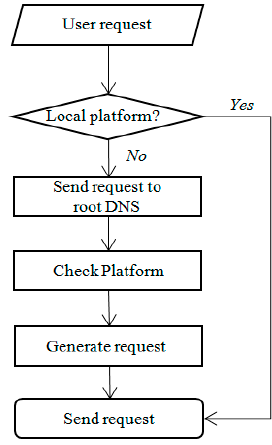
Figure 7. IoT device name system (DNS) algorithm.